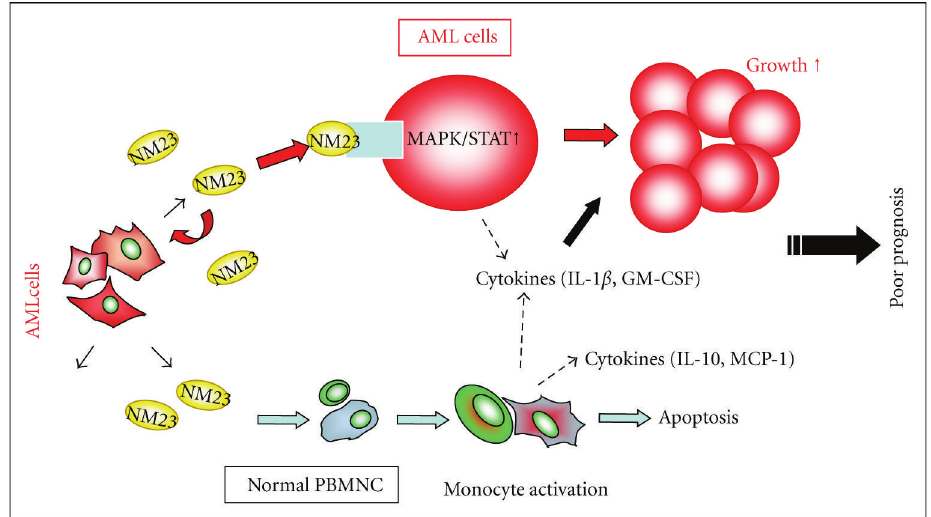
Figure 3: Extracellular function of NM23-H1 protein derived from tumor (AML) cells on primary cultured normal PBMNC and AML cells. Extracellular NM23-H1 protein promotes the growth/survival of primary AML cells mediated by MAPK activation, STAT activation, and cytokine release [33]. On the other hand, extracellular NM23-H1 protein a ff ects normal PBMNC survival, activates monocytes, and induces cytokine production [34]. Some of these cytokines, especially GM-CSF and IL-1 β , directly promote the survival/growth of primary cultured AML cells. Moreover, NM23-H1 induces immunosuppressive cytokine, such as IL-10. Therefore, the cytokine-inducing e ff ect of extracellular NM23-H1 protein on normal PBMNC may be associated with a poor prognosis in AML. Taken together, these observations suggest that extracellular NM23-H1 may play an important role in the malignant progression of leukemia and that inhibitors of extracellular NM23-H1 protein or inhibitors of extracellular functions of this protein should be evaluated for their